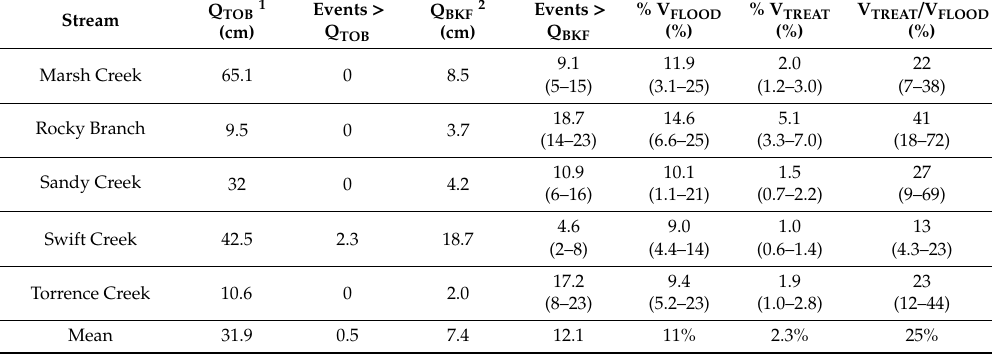
Table 3. Summary of the average annual number of storm events resulting in floodplain flow and the percent of the average annual total flow volume that is exposed to and potentially treated by the floodplain from 2008–2017. Bracketed numbers are the ranges of annual values.